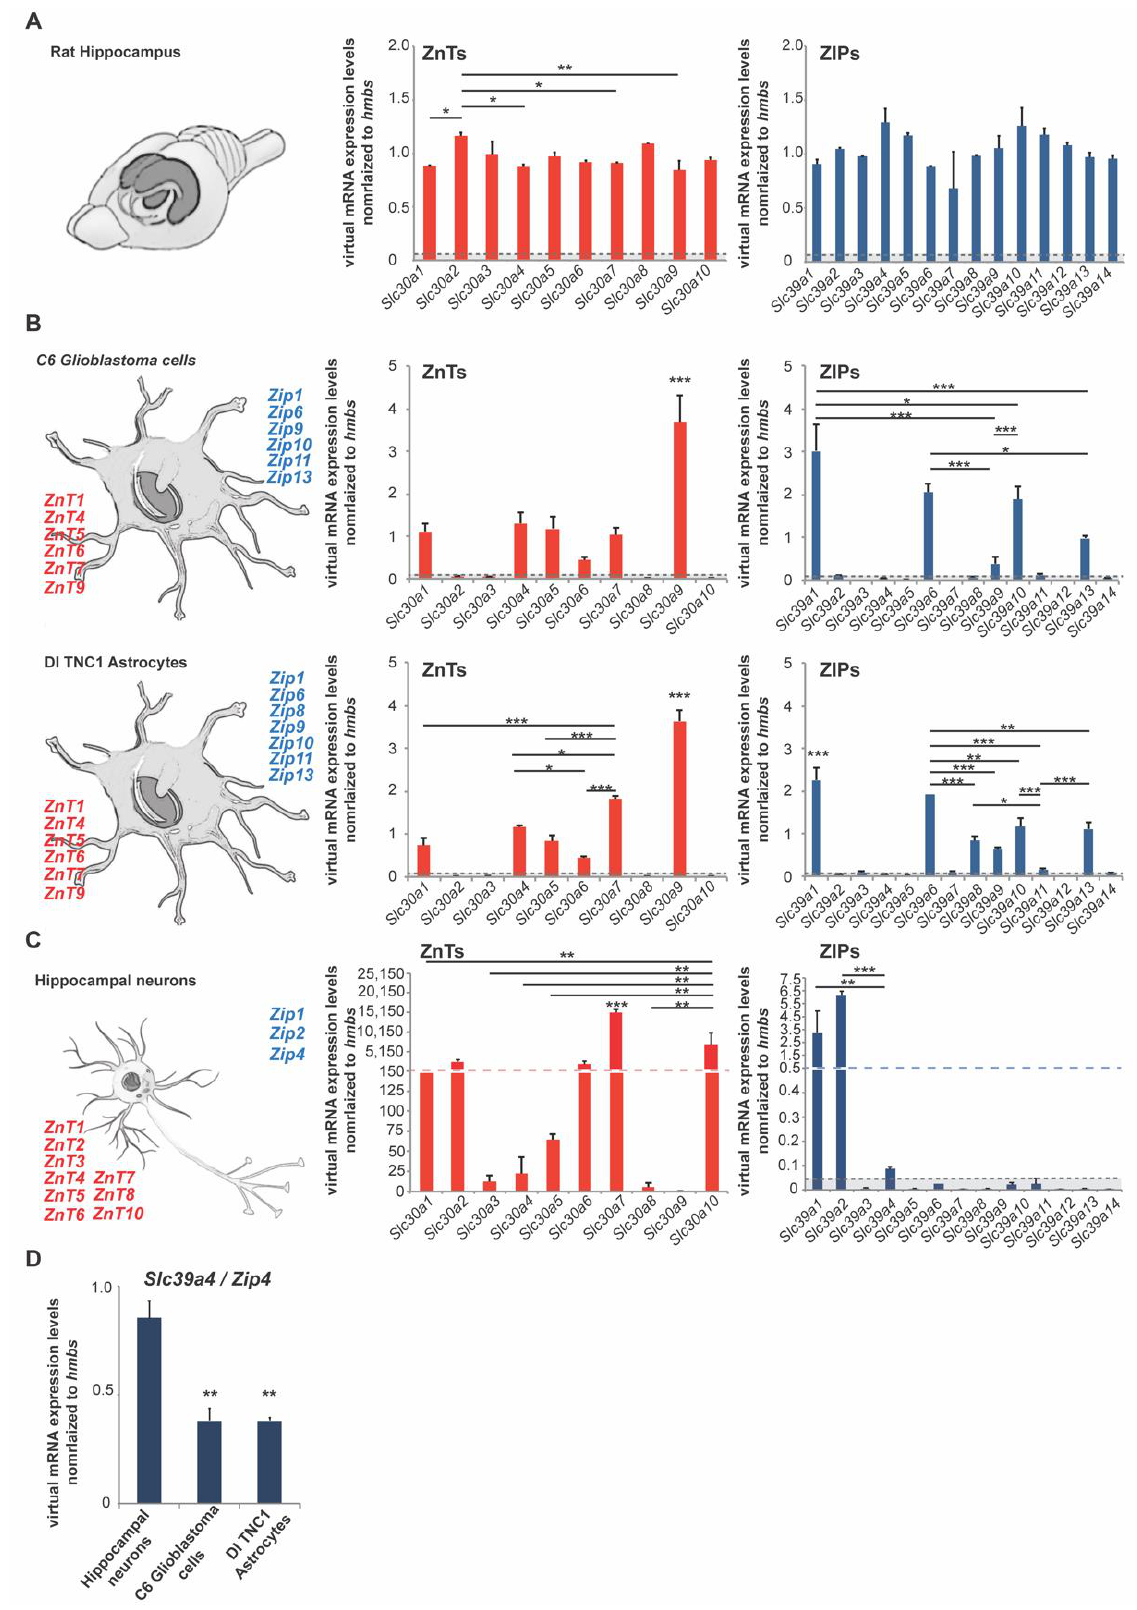
Figure 1. mRNA expression of zinc transporters in adult rat brain and rat neurons and astrocytes. mRNA expression was analyzed by qRT-PCR. mRNA levels are shown as average virtual mRNA concentration normalized to hmbs from three biological replicates measured in technical triplicates. ( A ) Hippocampal brain mRNA lysate was prepared from rats. The expression of all zinc transporters was detected in brain lysate. For a detailed statistical analysis, please see Supplementary Table S1A. ( B ) mRNA lysate was prepared from C6 glioblastoma cells and DI TNC1 astrocytes. Significant differential expression of zinc transporters was detected in both cell lines (one-way ANOVA, p Glioblastoma ≤ 0.0001, p DI TNC1 ≤ 0.0001). The